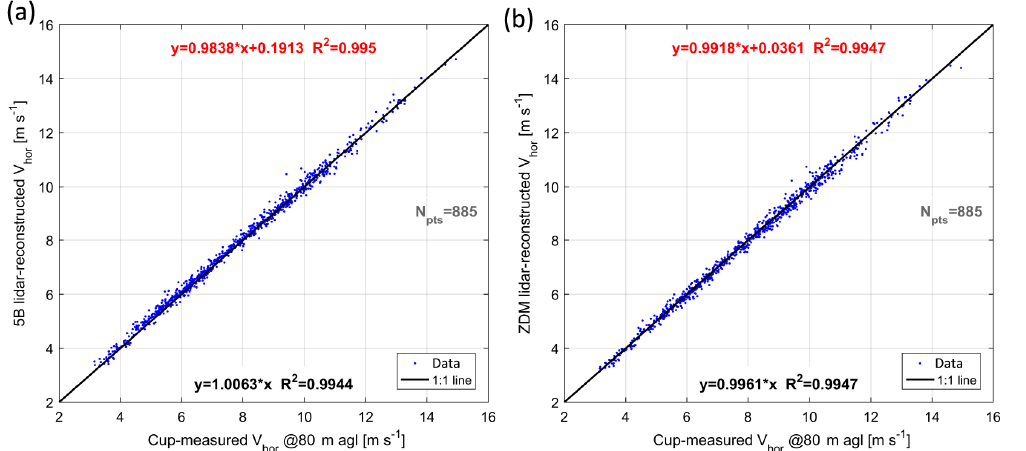
Figure 9. Comparison between mast-measured and lidar-estimated horizontal wind speed at hub height and 2 . 5 D rot using short-range measurements. (a) 5B-Demo lidar, using five LOS and four ranges. (b) ZDM lidar, using six LOS and three ranges.